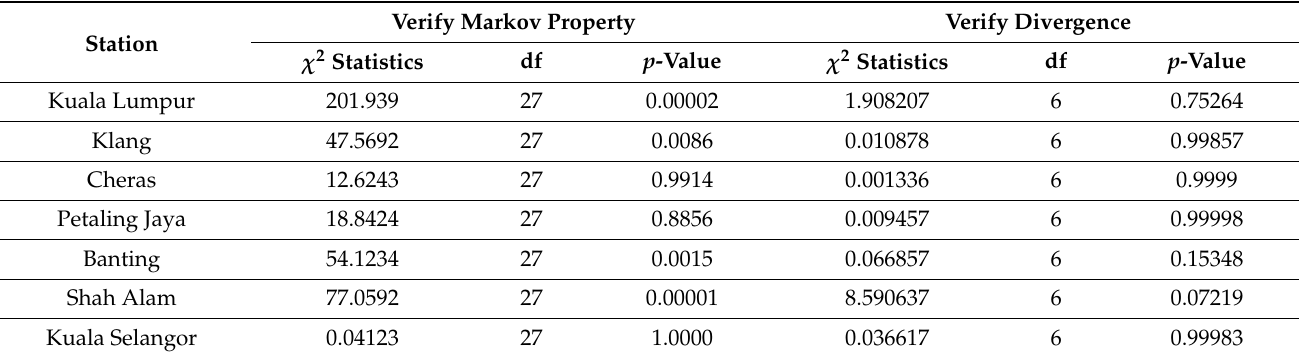
Table 2. The results of the χ 2 and divergence test of MC for all the stations.